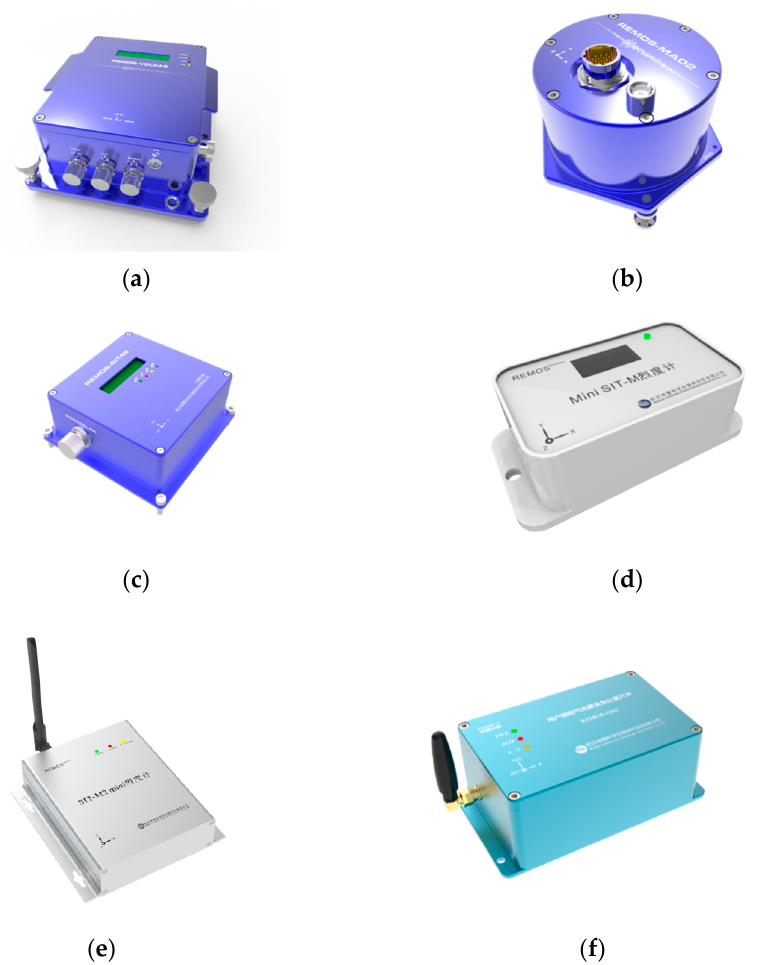
Figure 3. The strong earthquake monitoring equipment ( a ) is the integrated strong motion seismo- graph; ( b ) is the MEMS triaxial accelerometer; ( c ) is the high precision intensity meter; ( d ) is the first- generation simple intensity meter; ( e ) is the second-generation simple intensity meter; ( f ) is the seis- mic gas switch.